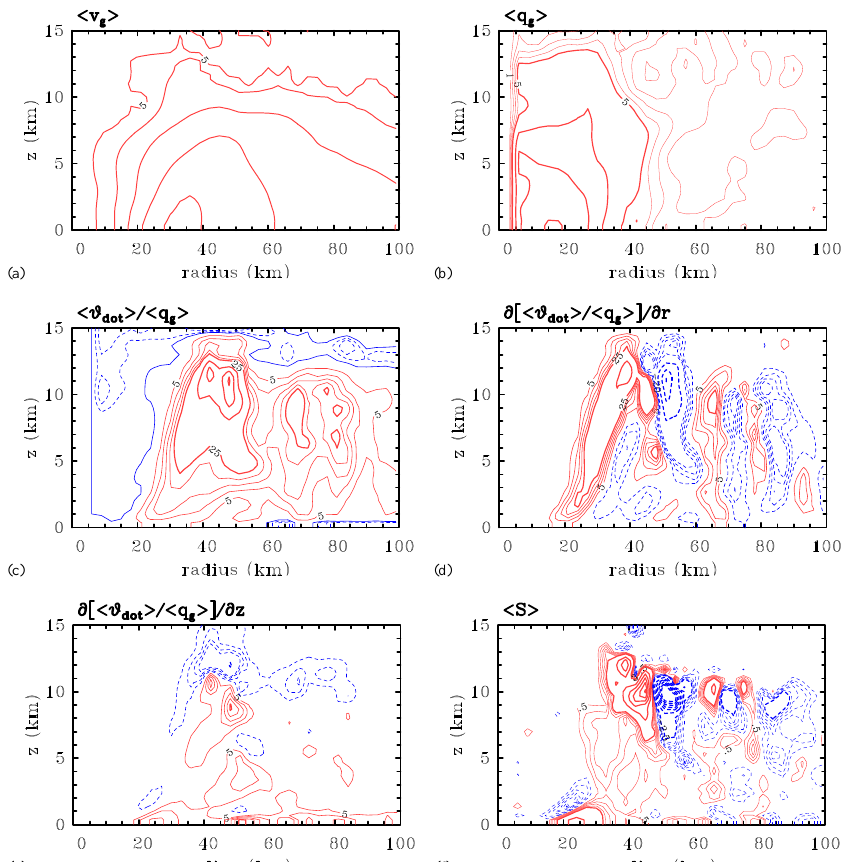
Fig. 8. Terms used in computing the spin-up function S for the simulation 3D3k at a time of rapid intensification (average between 65 and 69 h). (a) Theaxisymmetric-mean gradient wind, h v g i (Contour interval 5 ms − 1 ). (b) Axisymmetric-mean (Boussinesq) potential vorticity, h q g i , where the subscript ‘g’ denotes evaluation using the gradient wind (Contour interval: thin contours { 1, 2, 3, 4 } × 10 − 7 s − 3 ; thick contours { 5, 10, 15, 20 } × 10 − 7 s − 3 ). (c) Axisymmetric-mean diabatic heating rate divided by mean potential vorticity, i.e., h ˙ θ i / h q g i . (Contour interval: blue dashed contours { -2, -1 } × 10 − 3 K s 2 ; thin red contours { 5, 10, 15, 20 } × 10 − 3 K s 2 ; thick red contours { 25, 50, 75, 100 } × 10 − 3 K s 2 ). (d) Radial derivative of h ˙ θ i / h q g i (Contour interval: thin contours go from -2.5 to 2.5 in steps of 0.5 K s 2 m − 1 ; thick contours ± { 25, 75, 125, ... } K s 2 m − 1 ). (e) Vertical derivative of h ˙ θ i / h q g i (Contour interval: thin contours go from -2.5 to 2.5 in stepsof 0.5Ks 2 m − 1 ; thickcontours ±{ 25, 75, 125, ... } Ks 2 m − 1 ). (f)Spin-upfunction S ,withtherestrictionthat h q g i≥ max h q g i / 100 (Contour intervals: thin 0 . 5 × 10 − 5 up to ± 4 . 5 × 10 − 5 ; thick ± { 3, 8, 13, ... } × 10 − 5 s − 1 ).